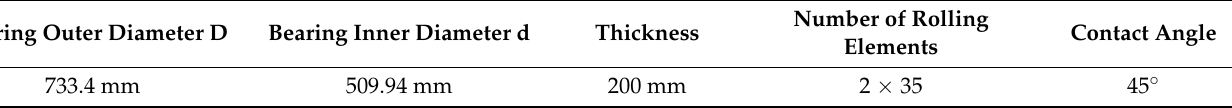
Table 2. Bearing parameters of indoor acoustic emission test